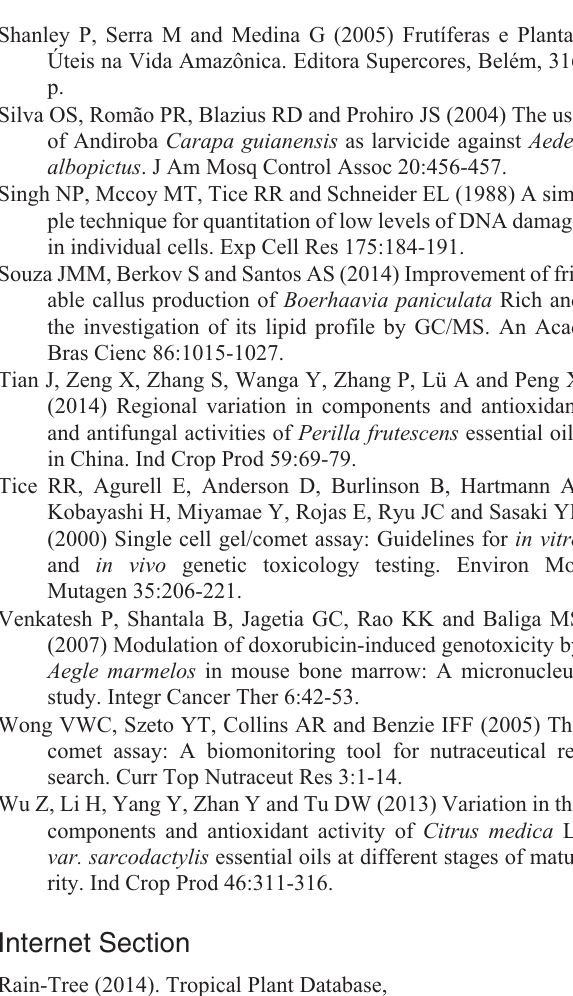
Figure S1 - Percentage inhibition of DPPH by Southeast (SE) samples 1-3. The points represent the mean (cid:5) SD of SE. Figure S2 - Percentage inhibition of DPPH by Northeast (NE) samples 1-3. The points represent the mean (cid:5) SD of NE. Figure S3 - Percentage inhibition of DPPH by Lower Amazon (LAM) samples 1-3. The points represent the mean (cid:5) SD of LAM. Figure S4 - Percentage inhibition of DPPH by Marajó (MAR) samples 1-3. The points represent the mean (cid:5) SD of MAR. Figure S5 - Percentage inhibition of DPPH by Metropolitan (MTR) sam- ples 1-3. The points represent the mean (cid:5) SD of MTR. Figure S6 - Percentage inhibition of DPPH by Southwest (SW) samples 1-6. The points represent the mean (cid:5) SD of SW. Figure S7 - Percentage inhibition of DPPH by commercial samples